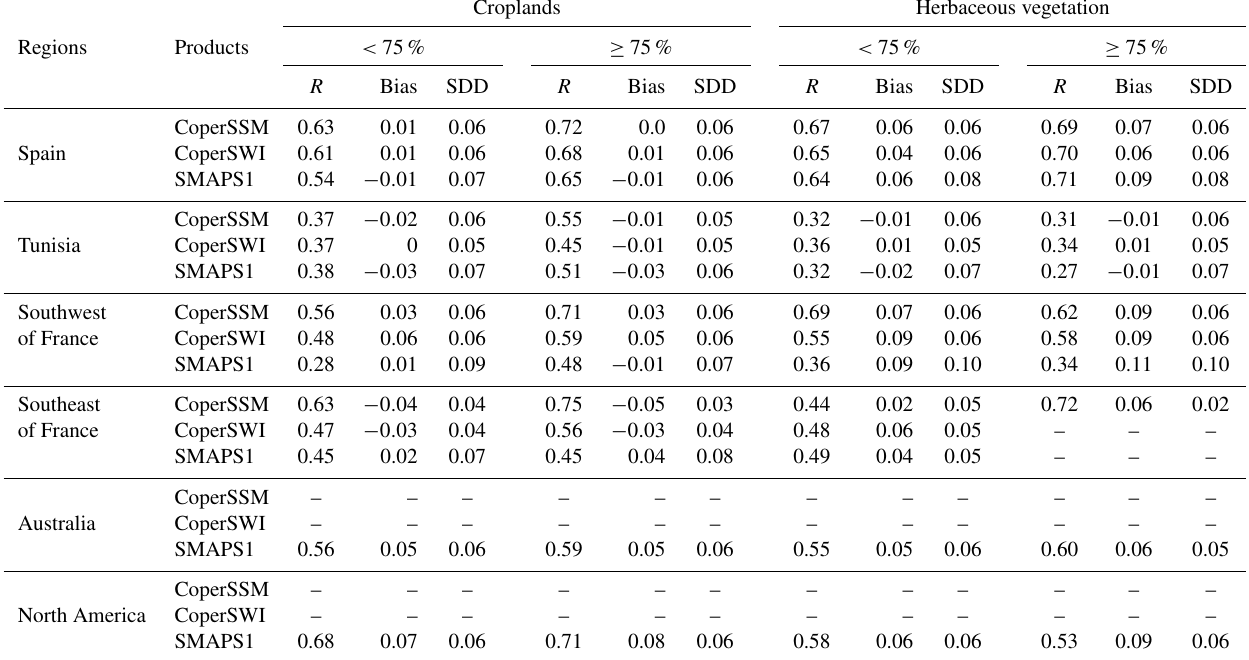
Table 2. Comparison of S 2 MP S1S3 with CoperSSM, CoperSWI, and SMAPS1, in terms of R , bias, and SDD, over 1km 2 pixels, where croplands or herbaceous vegetation are the dominant land cover classes, respectively. The metrics are also derived according to the degree of coverage of the land cover. One set of metrics is computed by considering only pixels covered by less than 75% of croplands or herbaceous vegetation. Another set of metrics is computed by considering only pixels covered by at least 75% of croplands or herbaceous vegetation. The analysis was performed from January to December